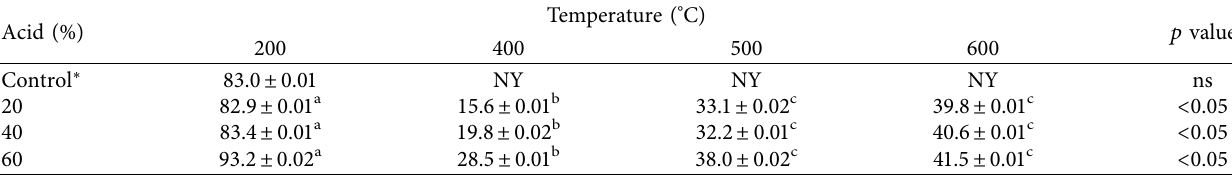
Table 1: Yield of activated carbon from H